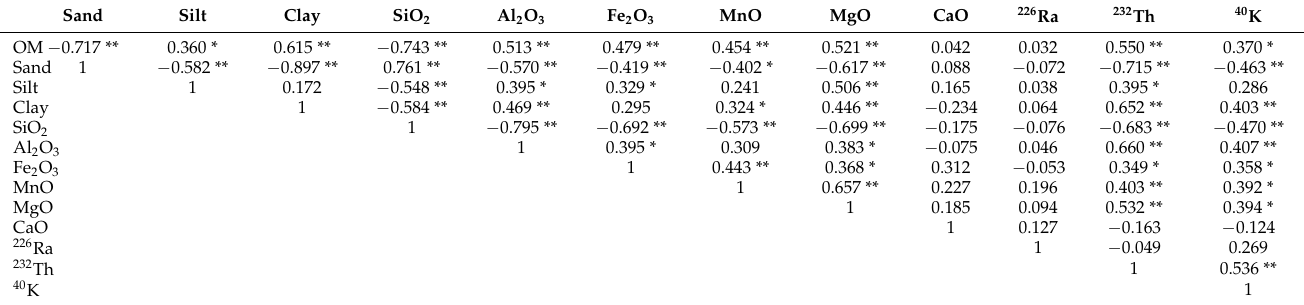
Table 4. Pearson’s correlation coefficient for the studied variables ( n =